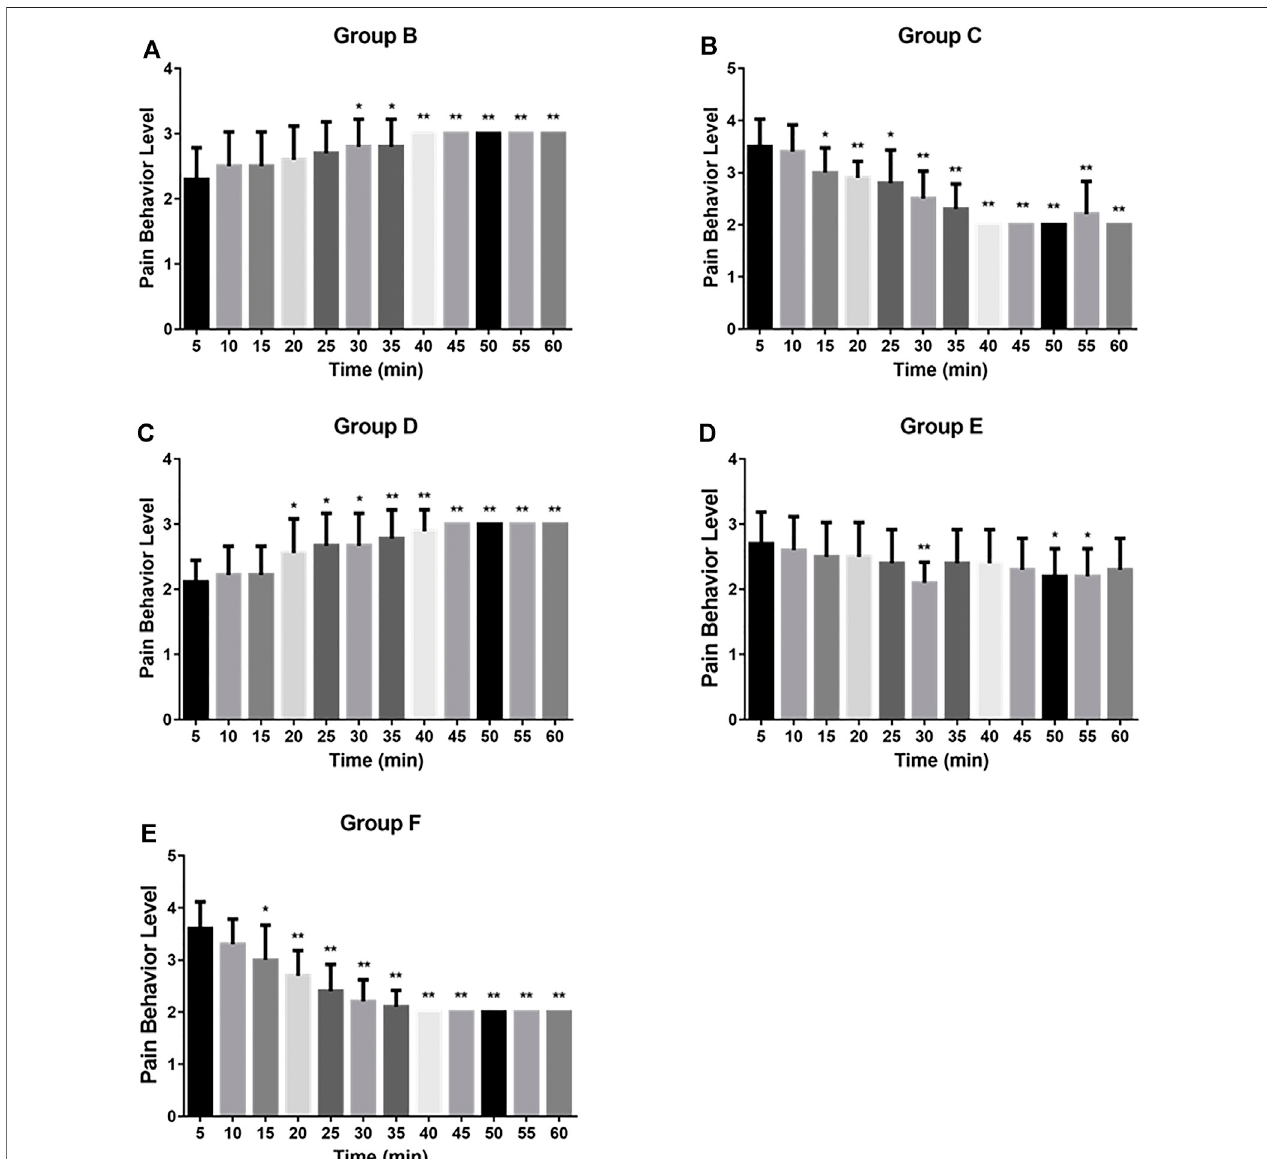
FIGURE 2 | The pain behavior level of rats by different fl urbiprofen ester microspheres delivery system in 60 min. (A) The pain behavior level of negative group in 60 min; (B) The pain behavior level of positive group in 60 min; (C) The pain behavior level of experimental group (2.25 mg/kg) in 60 min; (D) The pain behavior level of experimental group (4.5 mg/kg) in 60 min; (E) The pain behavior level of experimental group (9 mg/kg) in 60 min.